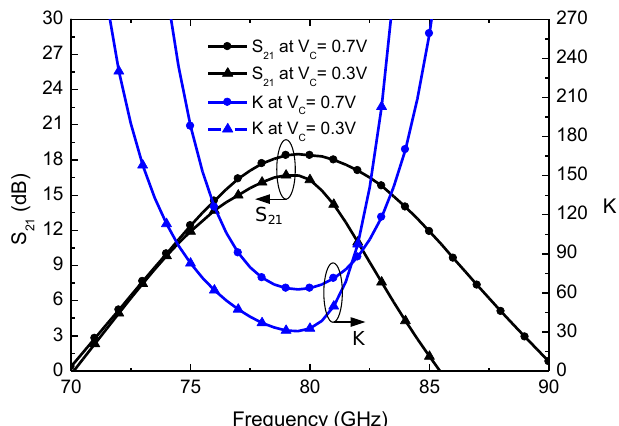
Figure 10. Simulated S-parameters and K of the W-band amplifier at two different varactor control voltages (V c = 0.3 and 0.7 V).